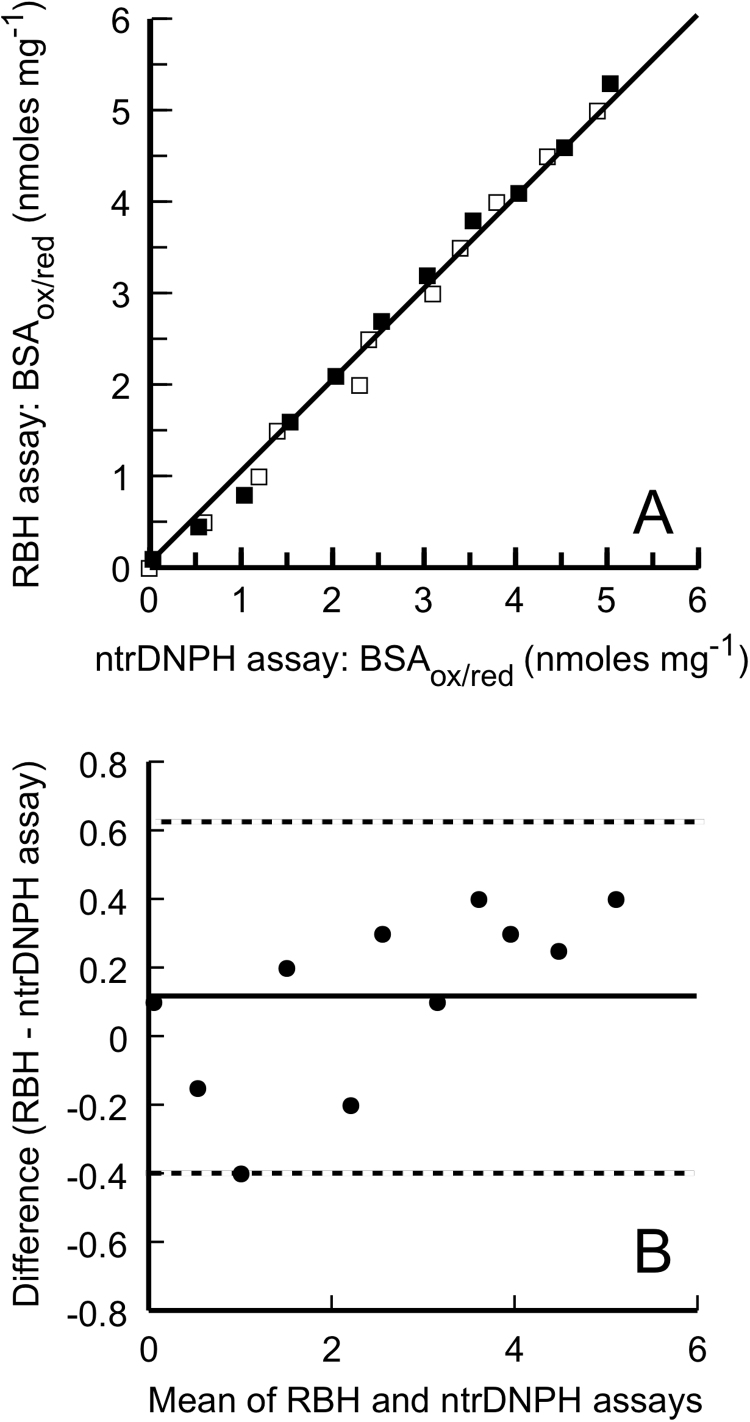
Statistical data coincidence comparisons between the RBH and the ntrDNPH assay. A) Plot of BSAox/red (i.e. BSAox in various mixture ratios with BSAred) carbonyl values obtained by the RBH assay (solid squares) and the ntrDNPH assay (open squares). The Pearson correlation (r) is 0.993 (at confidence interval 95%), and the solid line represents the line of identity. B) The Bland-Altman plot, with the dotted lines indicating 95% limits of agreement (− 0.3927 to 0.6335) and the thin solid line the mean difference (bias = 0.1182, with SD of bias 0.2629). Similar data (not shown) are obtained with lysozymeox/red and pepsinox/red protein mixtures.